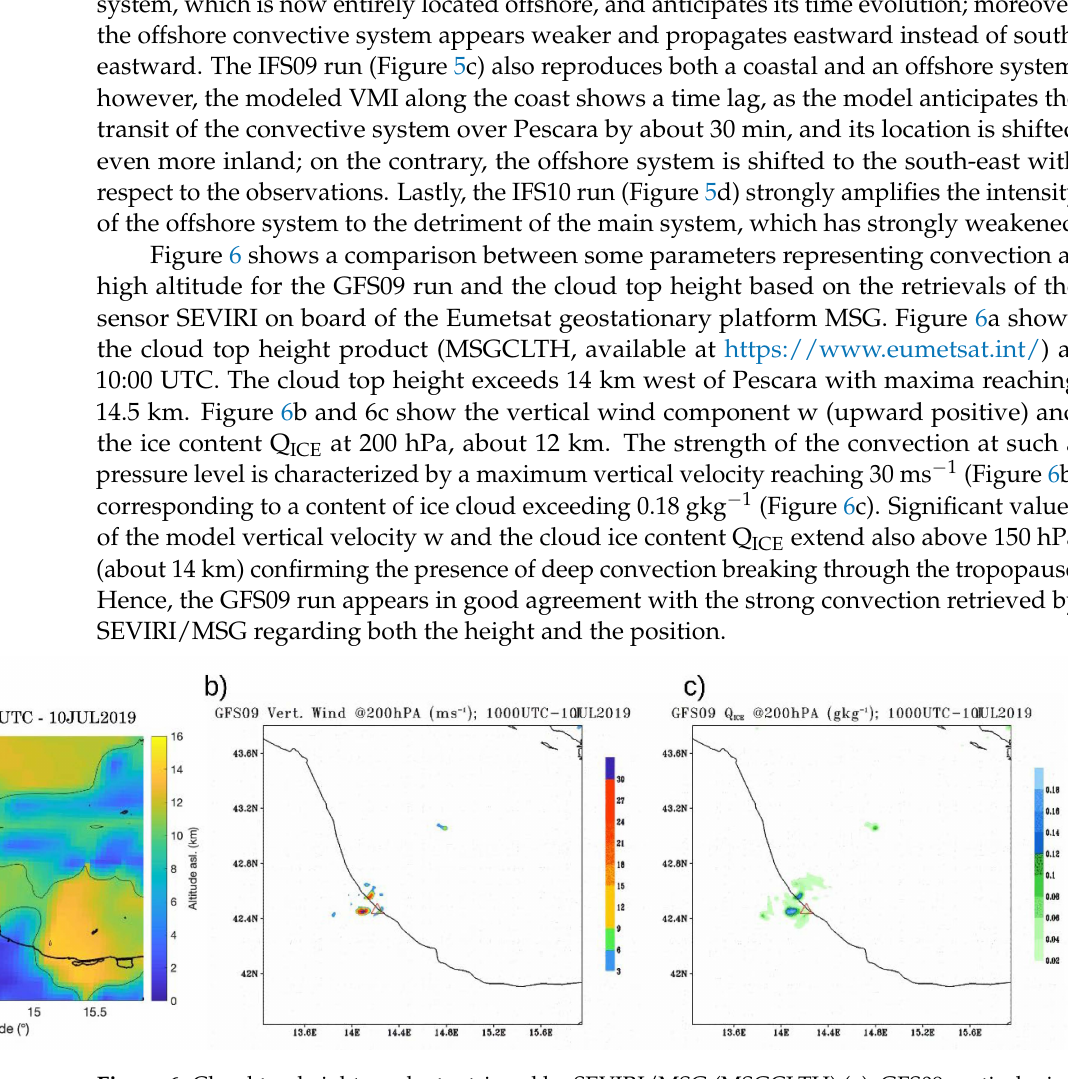
Figure 6. Cloud top height product retrieved by SEVIRI/MSG (MSGCLTH) ( a ), GFS09 vertical wind component w ( b ), and Q ICE ( c ) at 10:00 UTC 10 July 2019. The red triangle indicates the city of